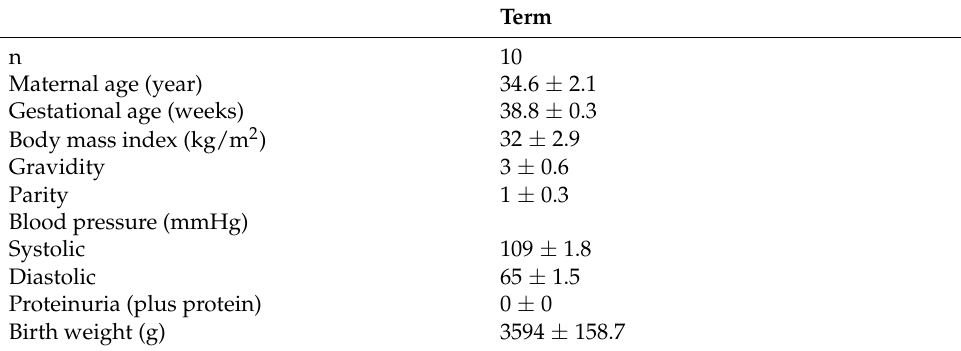
Table 1. Clinical parameters of participants.